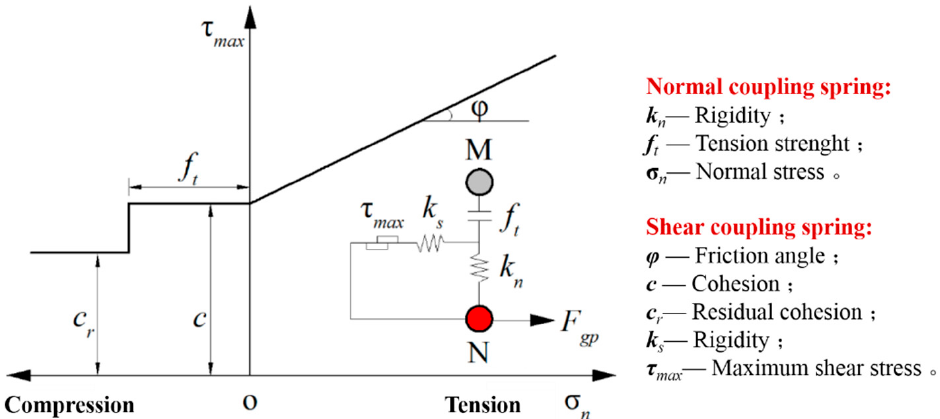
Figure 8. Interface behavior of liner structural elements.